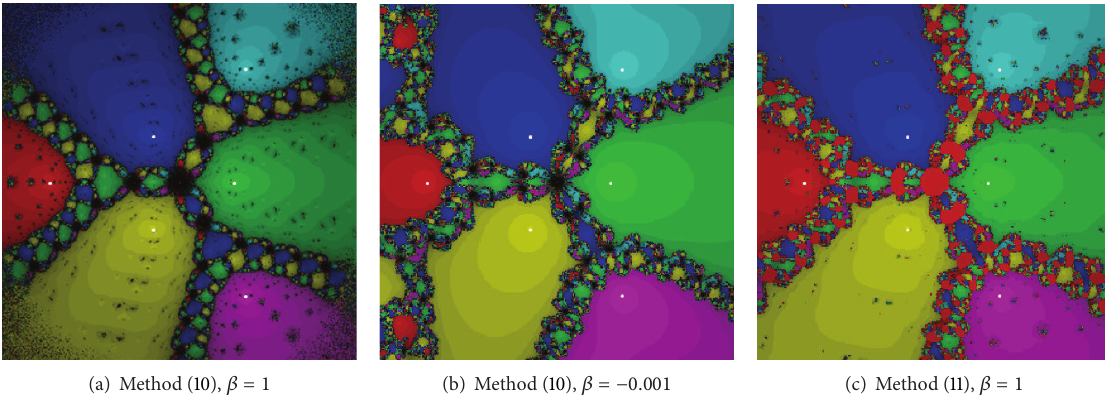
Figure 19: Basins of attraction for the test problem